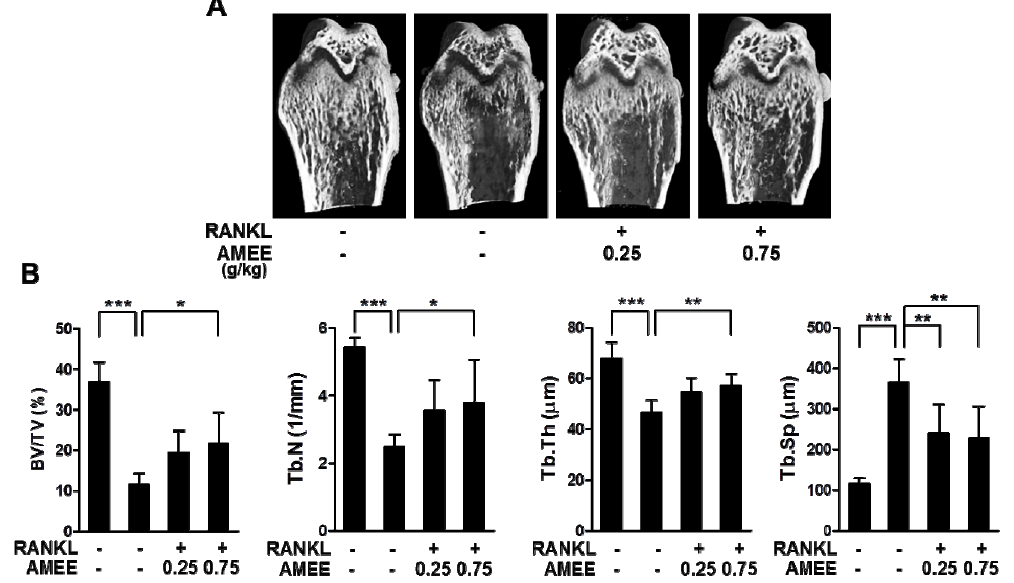
Figure 5. Effect of AMEE on RANKL-induced bone loss in vivo . Mice were orally administrated with AMEE (0.25 and 0.75 g/kg) at 12 h intervals for 5 consecutive days (day -2 to 2), and RANKL (1 mg/kg) was injected intraperitoneally on days 0 and 1. The femora were collected on day 3 and analyzed by micro-CT scanning. ( A ) Representative micro-CT images of the distal femora. ( B ) Trabecular bone volume/tissue volume (BV/TV), trabecular number (Tb. N), trabecular thickness (Tb. Th), and trabecular separation (Tb. Sp) at the distal femoral metaphysis. * p < 0.05; ** p < 0.01; *** p <